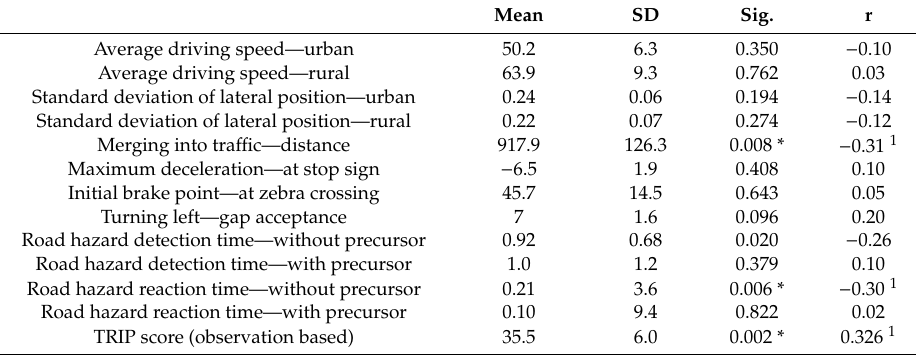
Table 2. Descriptive statistics and correlation coe ffi cients of the simulated driving